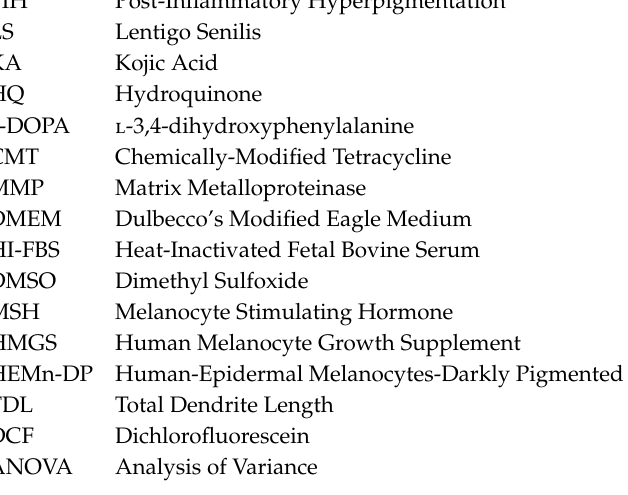
Table S1: Kinetic parameters of inhibition of mushroom tyrosinase by CMT-308; Figure S1: MTS cytotoxicity assay for evaluating cellular viability of HaCaT cells treated with CMT-308 for 72 h; data are mean ± SD of two independent experiments; ** p < 0.01 vs. Ctrl, one-way ANOVA with Dunnett’s test. Figure S2: ( A ) Representative FM-stained images of HEMn-DP cocultures of untreated (Ctrl) and CMT-308 (10 µ M)-treated group for 72 h; 40 × objective magnification; ( B ) quantitation of melanosome particles in keratinocytes; data are mean ± SD of triplicates; no significance was found by student’s t